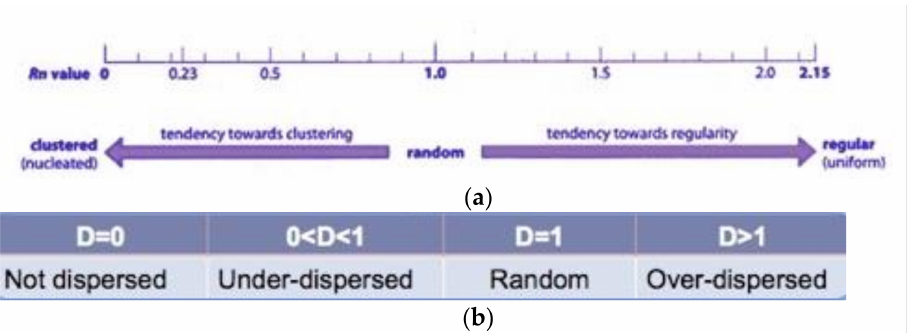
Figure 11. ( a ) Range of the Clark-Evans nearest neighborhood; ( b ) range of the variance to mean ratio test.